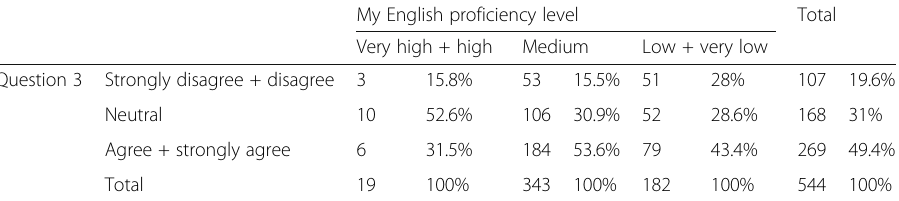
Table 7 Students ’ English proficiency level and their English learning orientation